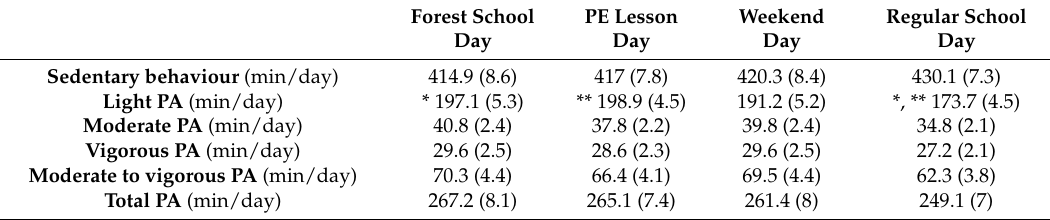
Table 2. Mean (standard error in parentheses) sedentary behaviour, light PA, moderate PA, vigorous PA, and total PA for Forest School (FS) days, Physical Education (PE) lesson days, weekend days, and regular school days adjusted for accelerometer wear time ( n = 36, boys: n = 17, girls: n = 19).